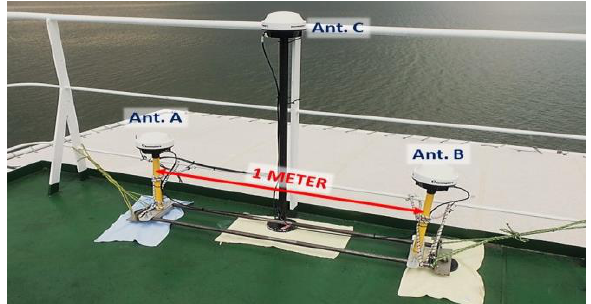
Figure 7. Antenna (Ant.) setup on upper deck of the vessel